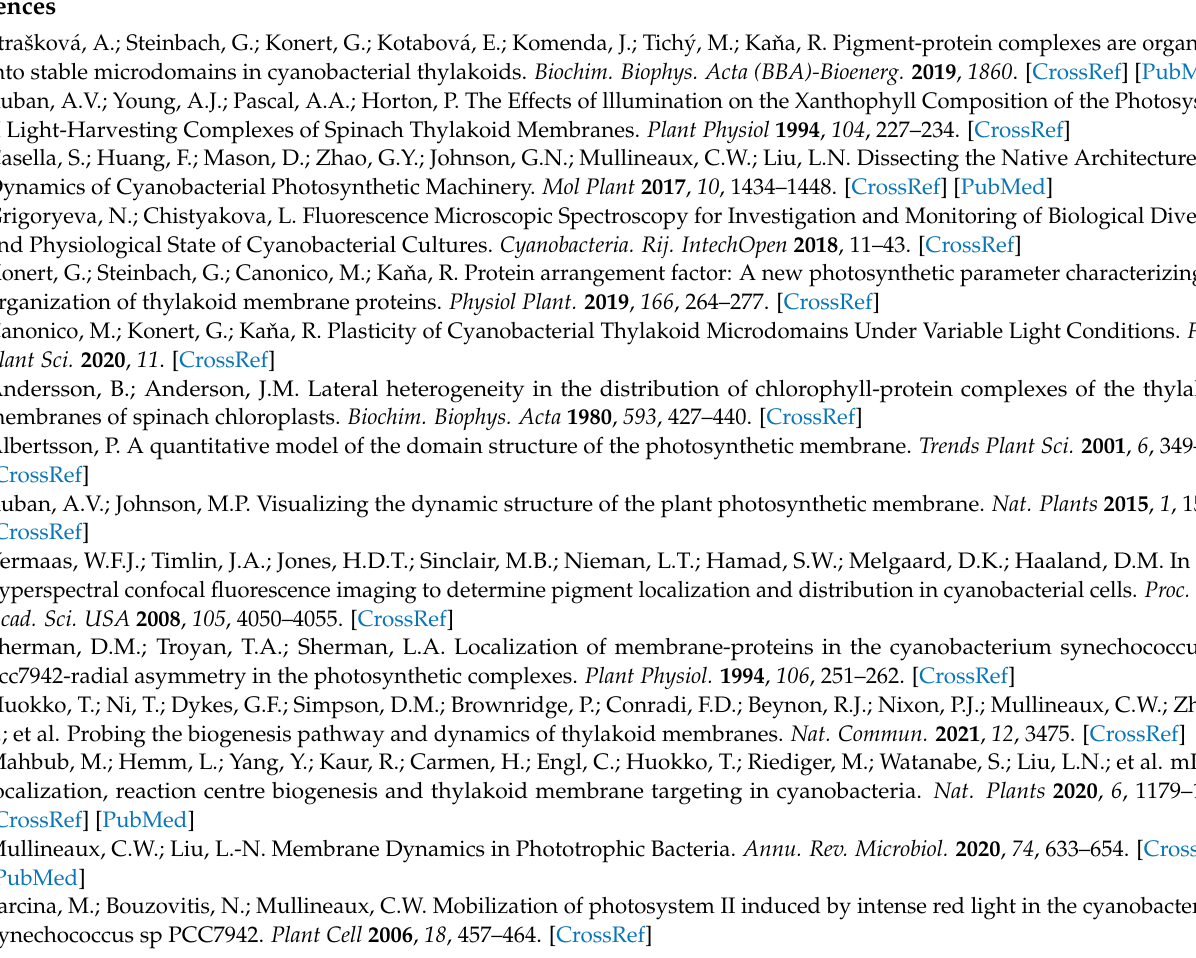
centration per cell, Figure S6: Absorption spectra of extracted pigments, Figure S7: Protein composition analysis from CN gel of HL treated culture, Figure S8: Identification of G